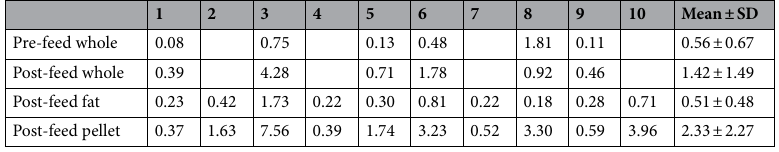
Table 1. Concentration (ng/µl) of total DNA in different human milk fractions by individual (n =